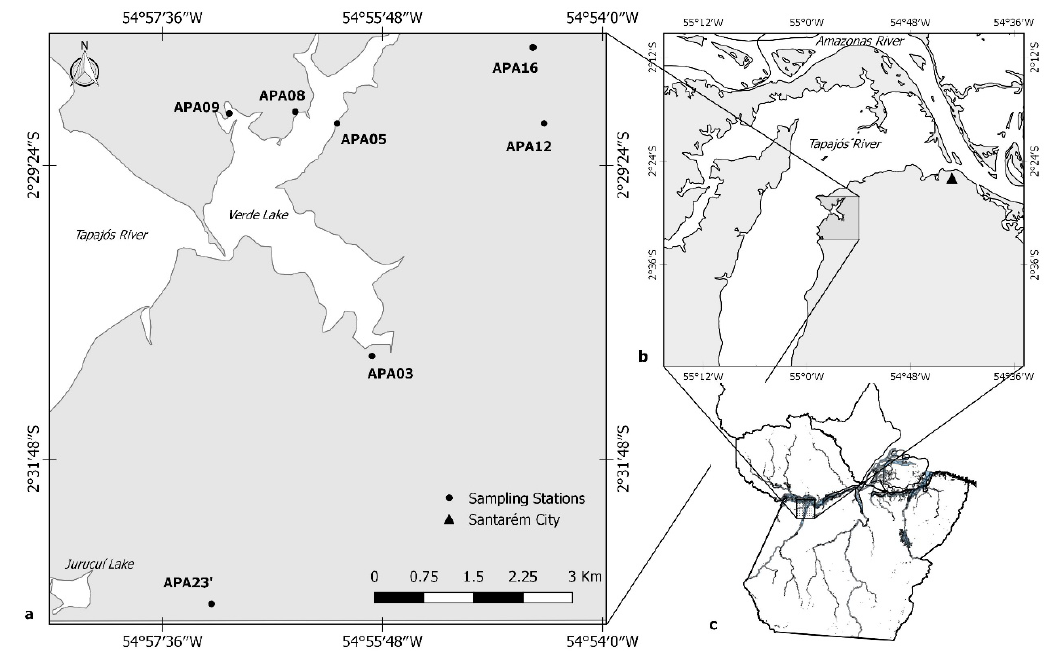
Figure 1. Maps of the study area showing the locations of the sampling stations (a), in the lower Tapajós River region (b) of Pará State